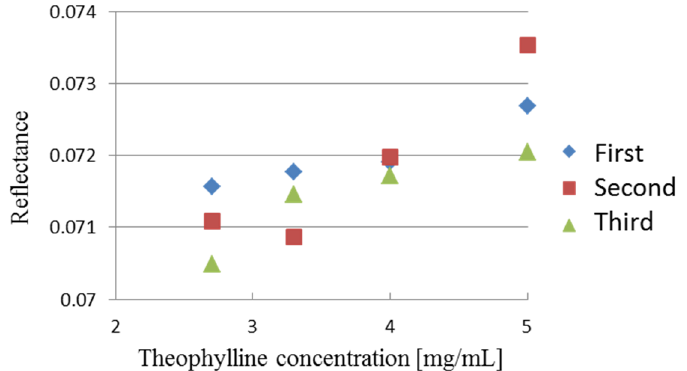
Figure 4. Theophylline concentration dependence of the reflectance of THz ATR spectra at 0.164 THz. With an increasing concentration, reflectance also increases. Errors were within ±0.0003.